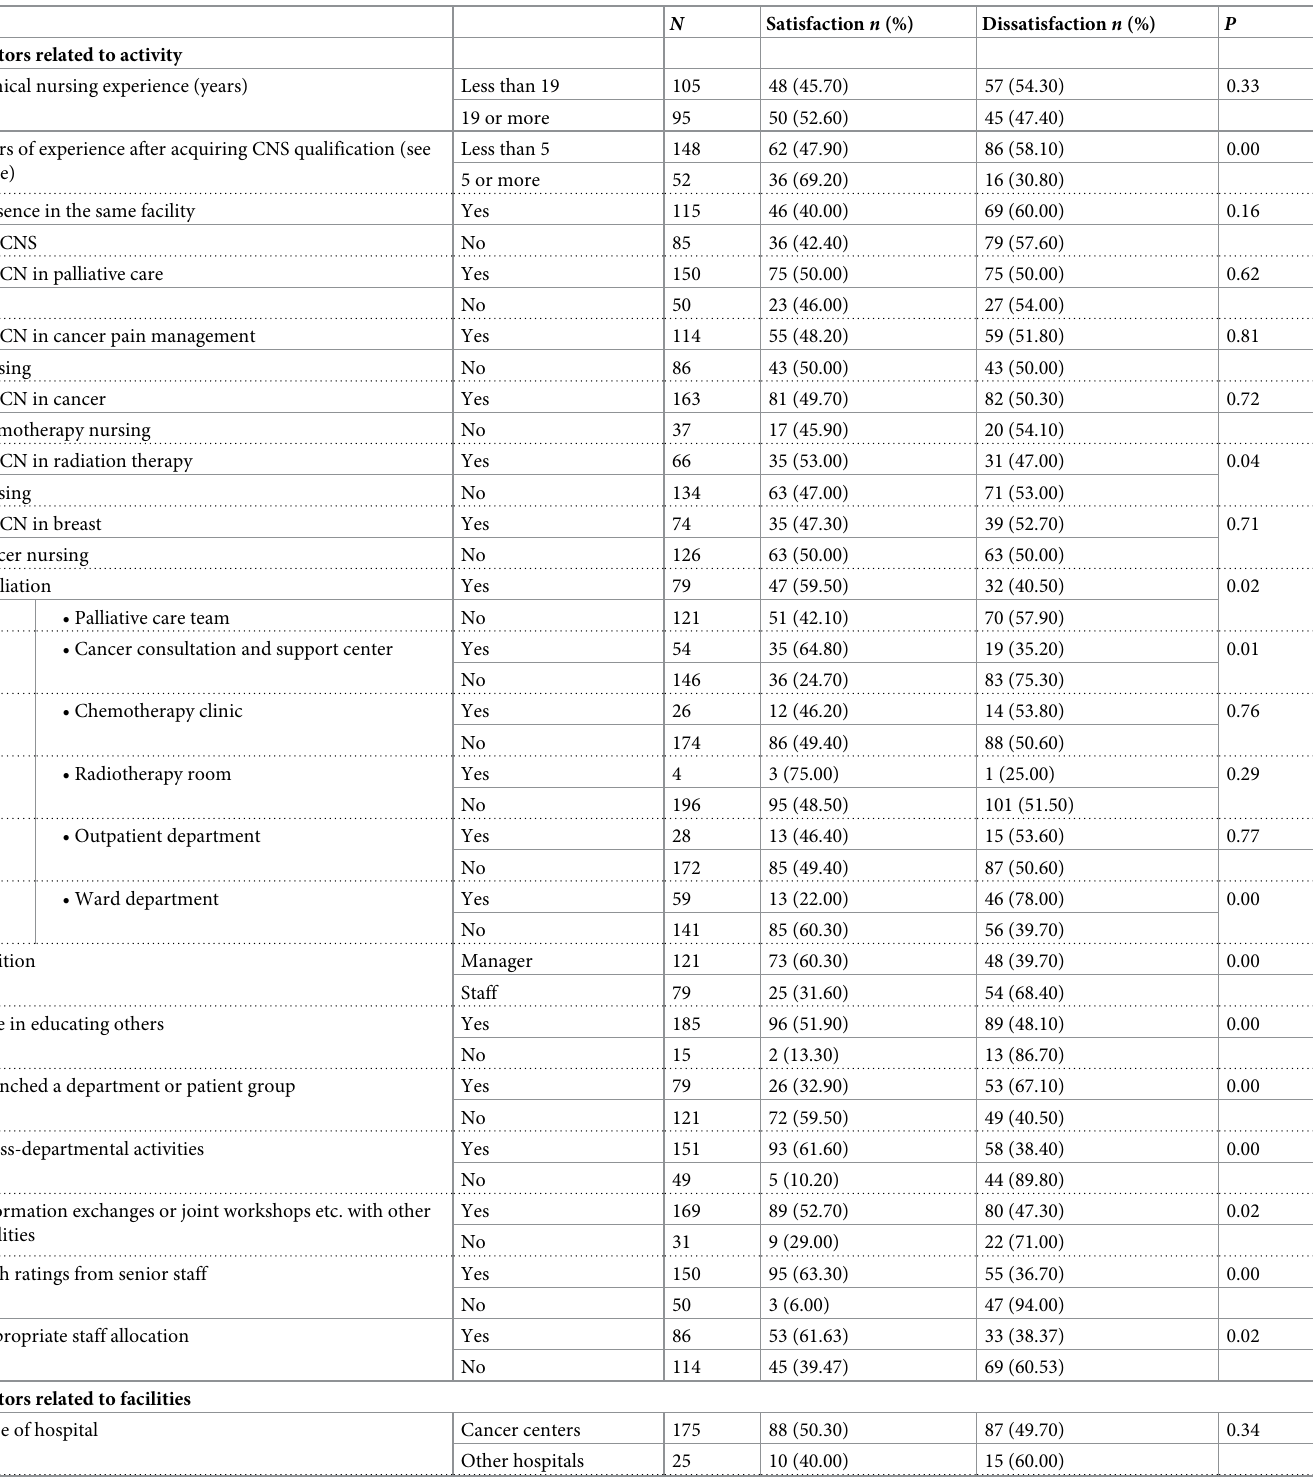
Table 3. Univariate analyses for